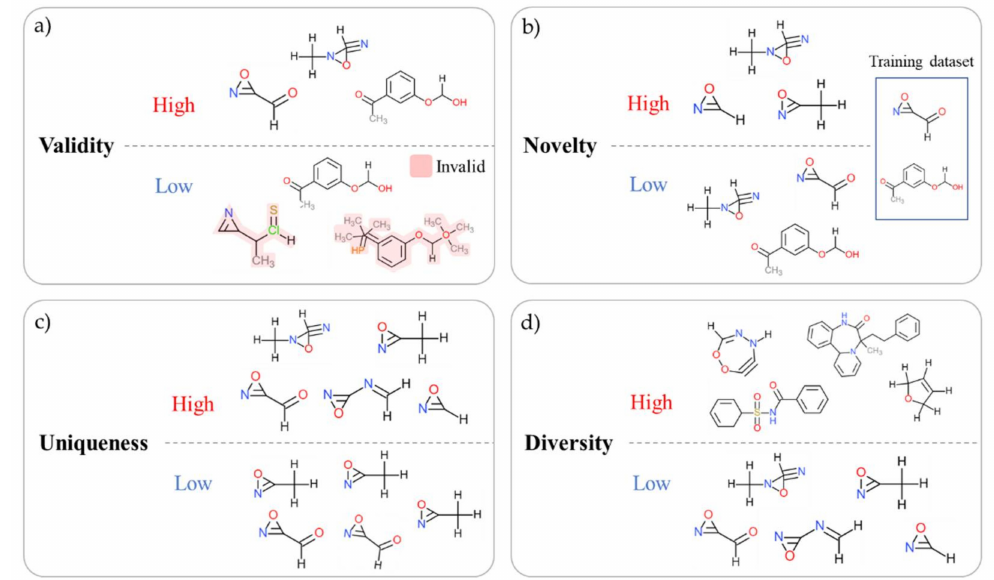
Figure 7. Generation metrics for de novo drug design. The four generation indices are commonly used in the de novo drug design studies: ( a ) validity, ( b ) novelty, ( c ) uniqueness, and ( d ) diversity. Unlike other metrics, a training dataset is required to measure